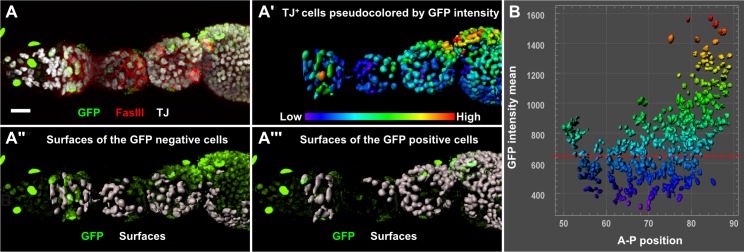
Quantification of MARCM clone sizes.(A) 3D rendering of an ovariole with a GFP+ MARCM clone stained for FasIII (red), GFP (green) and traffic jam (white). All surfaces, colored according to the mean intensity in the GFP channel, are shown in A’, GFP– surfaces shown with the GFP channel (green) in A’ and GFP+ surfaces shown with the GFP channel in A’’’. Images were analyzed and surfaces arrayed on a scatter plot (B) as described for negatively marked clones (Figure 4).